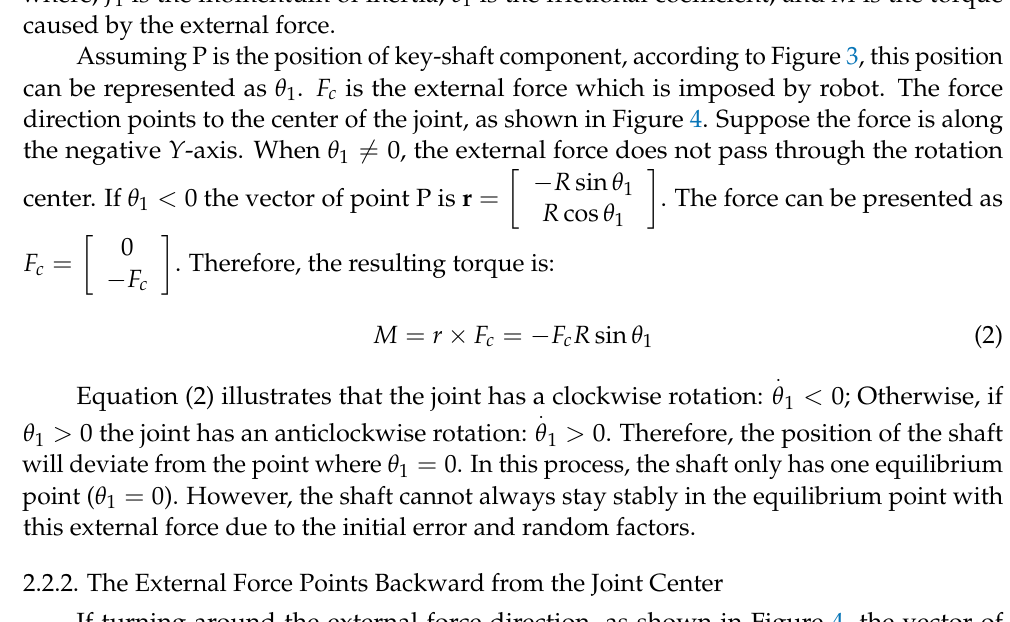
where, J 1 is the momentum of inertia, c 1 is the frictional coefficient, and M is the torque caused by the external force.